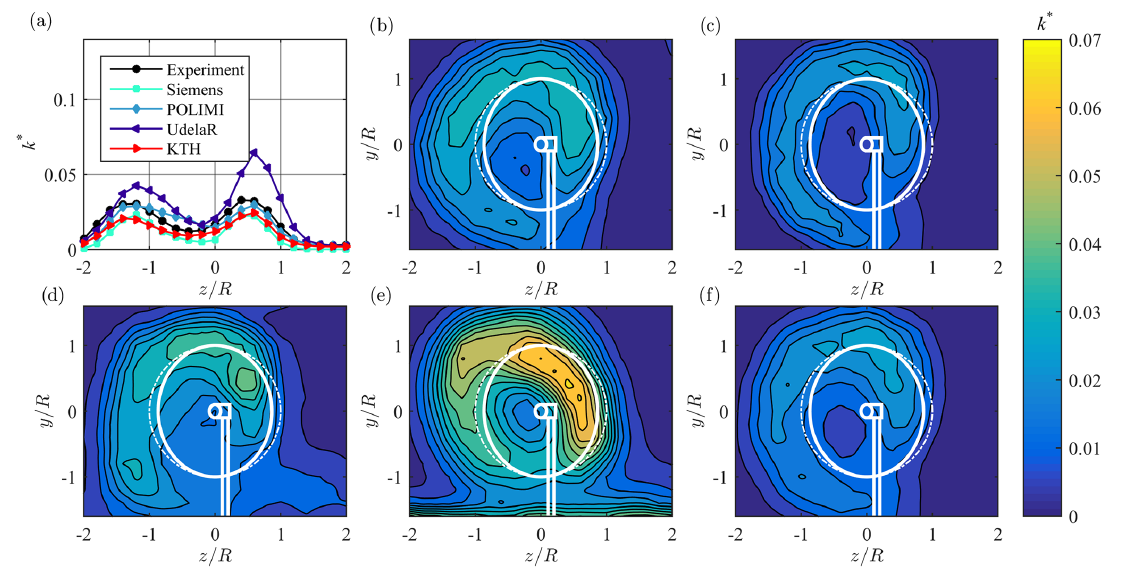
Figure 13. (a) Line plot at hub height and (b–f) contour plots for normalized turbulent kinetic energy (TKE) k ∗ in the wake 3 D behind downstream turbine T2, from (b) experiments, (c) Siemens, (d) POLIMI, (e) UdelaR, and (f) KTH. The white lines represent the turbine rotor, nacelle, and tower; solid lines γ = 30 ◦ ; dashed lines γ = 0 ◦ . Table 5. Comparison parameters: skew angle ( ξ ), wake deflection ( δ ) and available power in the wake ( P ∗ measurements. Statistical performance measures are NMSE and r for u ∗ , v ∗ , and k ∗ at 3 D behind downstream turbine T2.